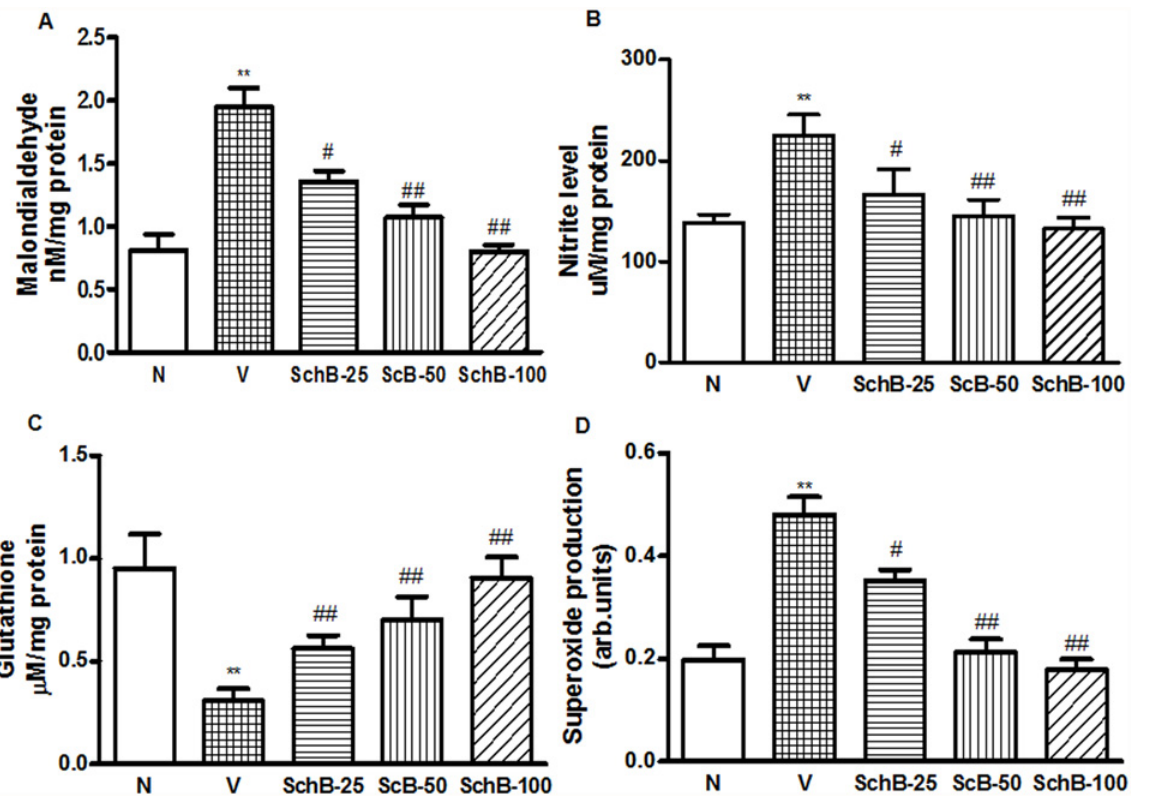
Fig 7. Sch B attenuates Dox-induced myocardial ROS and oxidative stress, and enhance antioxidant enzyme. (A) MDA level, (B) Nitrite level, (C) Glutathione level and (D) Superoxide production by LV homogenates. ** P < 0.01 vs. group N mice; # P < 0.05 and ## P < 0.01 vs. group V